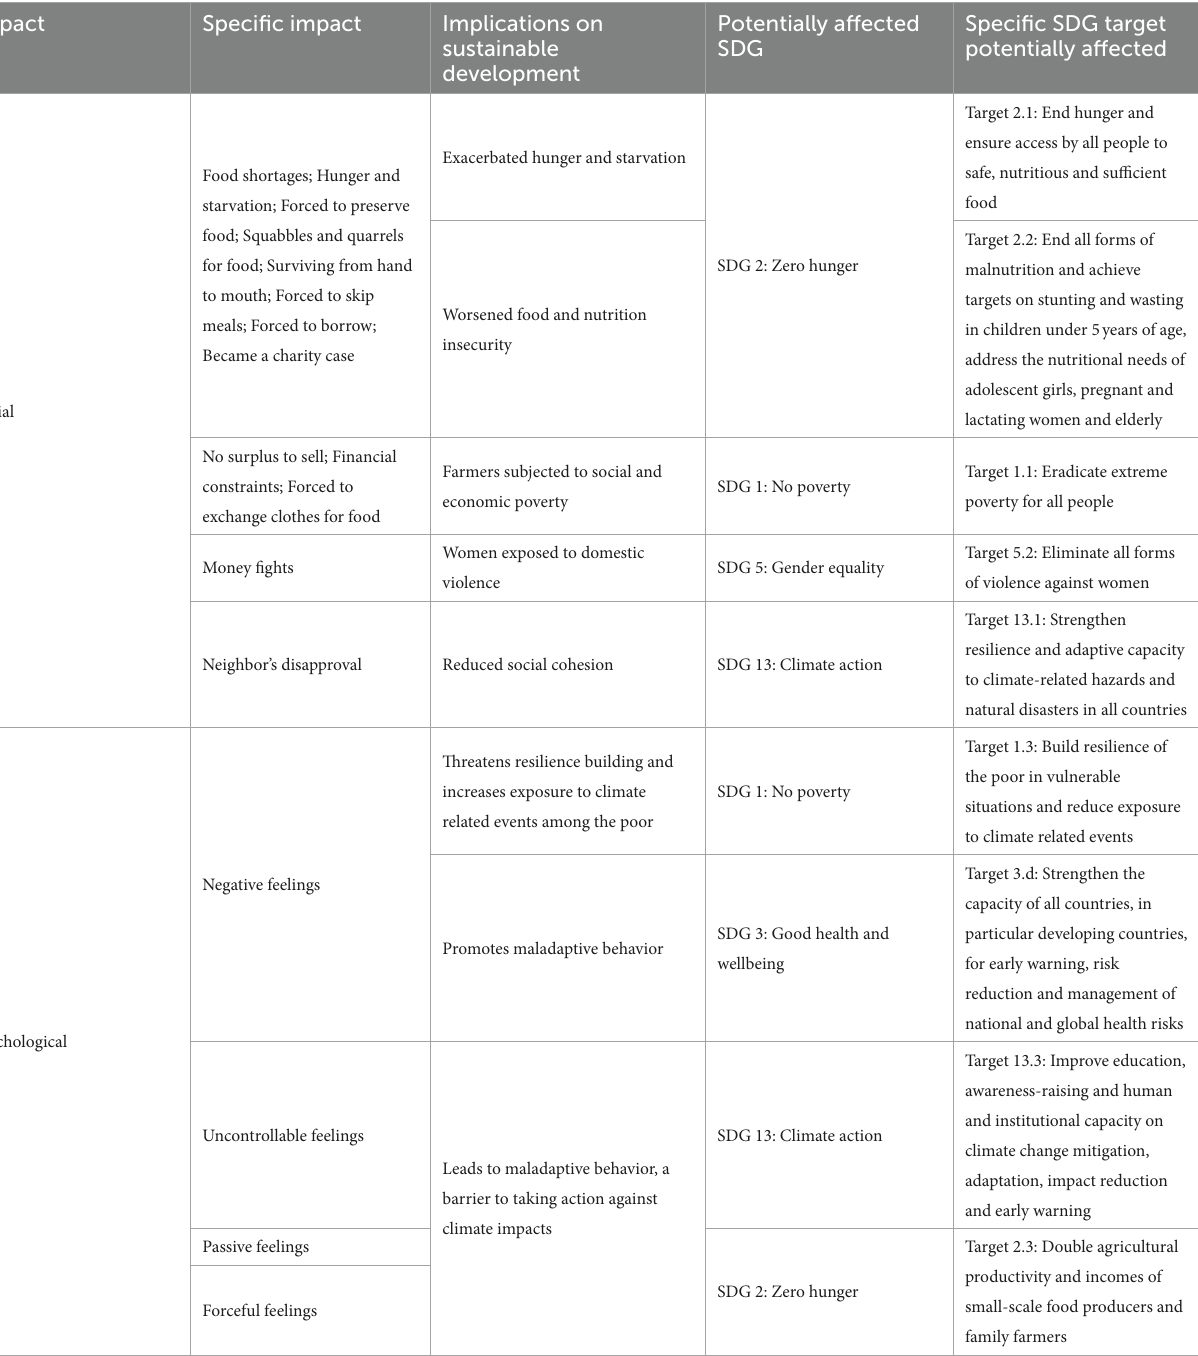
TABLE 2 Implications of psychosocial impacts of climate change on sustainable